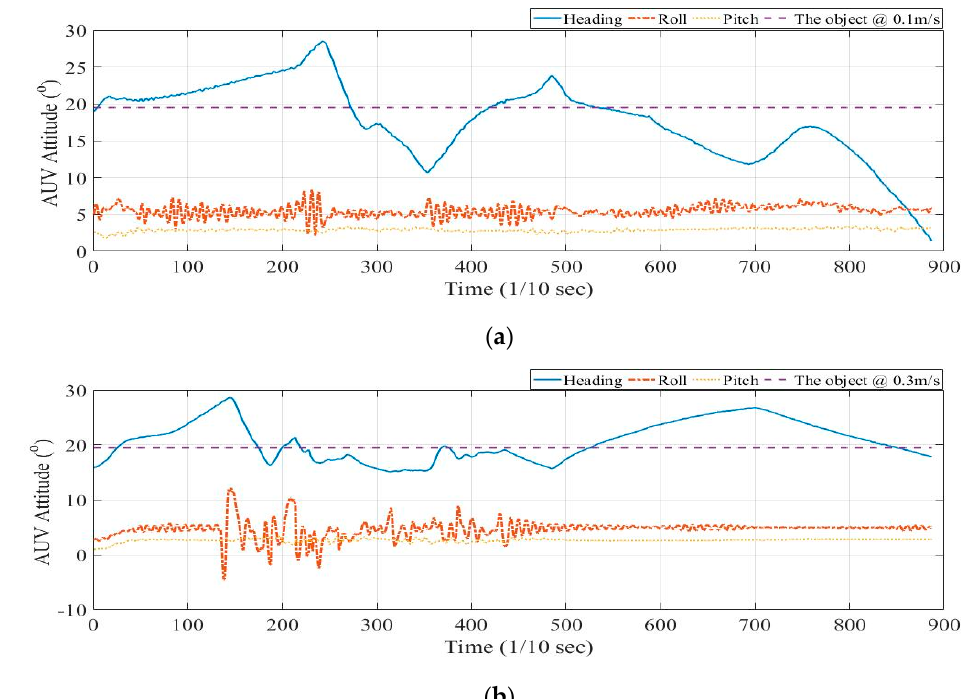
Figure 17. Trajectories of ( a ) AUV in the towing tank, ( b ) visual coordinates, and ( c ) rudder angles.